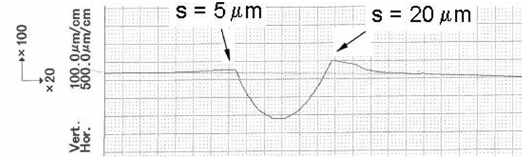
Figure 5. Example of the largest variation in pile-up depth, s , for AA1350-H24 alloy tested with a 3.175 mm diameter